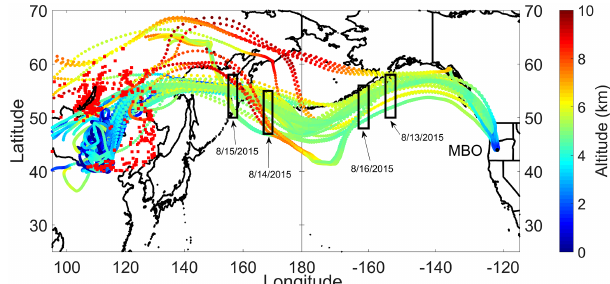
Figure 5. Most of the HYSPLIT back trajectories for Siberian events (events 10–15) plotted as a function of altitude. Roughly 10% of the back trajectories that did not follow the main transport track were not plotted. Forest fires from 7 to 16 August 2015 iden- tified by the Fire INventory from NCAR (FINN) fires are marked by red squares. These transects are not sequential and do not track one plume of Siberian smoke, but rather they illustrate the extensive eastward transport of Siberian smoke over the course of the week. The four black boxes represent the locations of smoke plumes iden- tified by CALIPSO cross sections detailed in Figs.